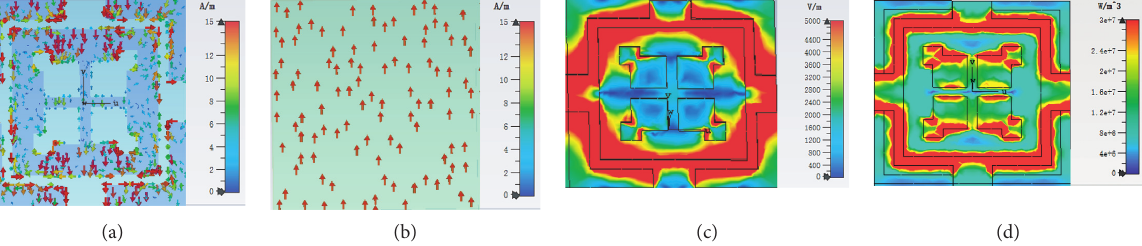
Figure 9: (a) The top surface current distribution; (b) the current distribution on the ground; (c) electric field distribution; and (d) energy loss distribution of the absorber.